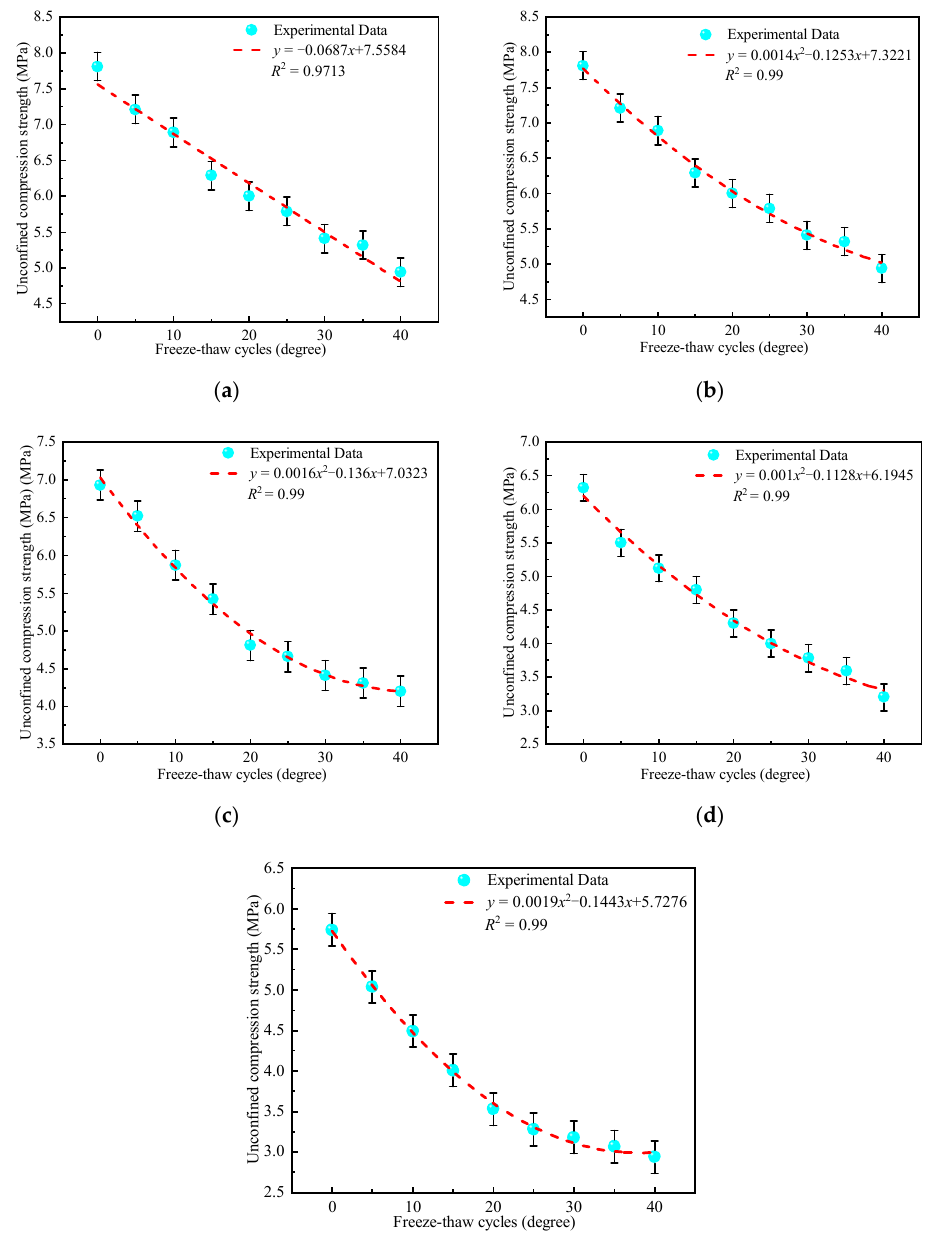
Figure 7. Relationship between unconfined compressive strength and freeze-thaw cycle: ( a ) CFRBCA1, ( b ) CFRBCA2, ( c ) CFRBCA3, ( d ) CFRBCA4, ( e ) CFRBCA5. It can be observed from Figure 7 that the compressive strength of CFRBCA decreased as the number of freeze-thaw cycles increased. The compressive strength and number of freeze-thaw cycles conformed to a fitted function, with a correlation coefficient R 2 greater than 0.97, reflecting a good correlation between the number of freeze-thaw cycles and unconfined compressive strength. The compressive strength of the CFRBCA with different compositions decreased as the brick content was increased. Specifically, the